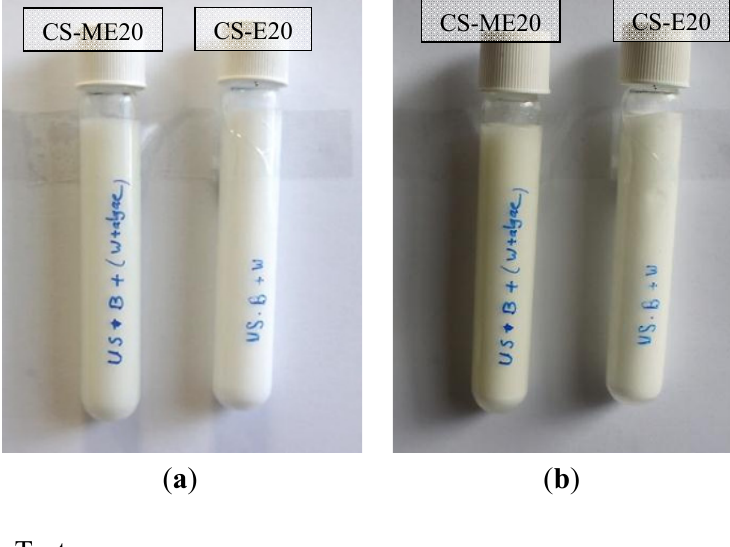
Figure 9. The emulsion fuels samples, ( a ) after four hours; ( b ) after two